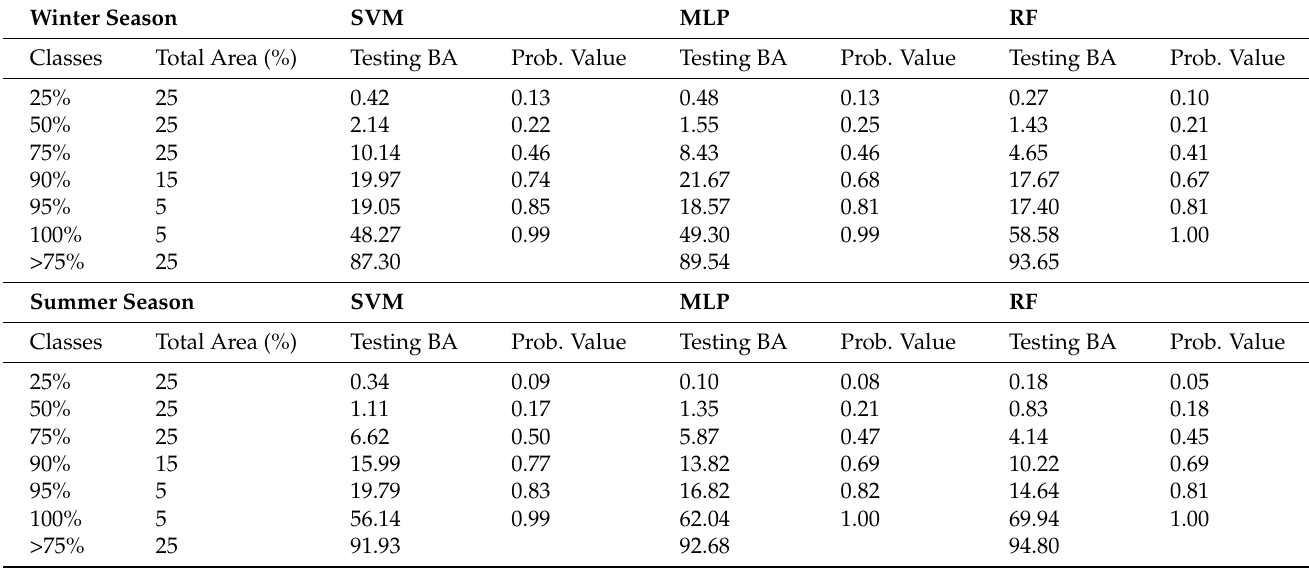
Figure 6. ROC curves for the three ML algorithms with the corresponding AUC values. Table 3 shows the percentage of burned area in the testing dataset (Testing BA) within each percentile class range (Classes) and the corresponding probabilistic predicted value (Prob. Value). The same percentile range’s limits can correspond to different values of the probabilistic output, allowing the competent authority the make decisions based on a given threshold for the highly susceptible area rather than on the raw output values. A model that predicts good results is expected to produce a higher percentage of the testing burned area within the highest percentile ranges and a lower percentage in the lowest ranges. Indeed, this is exactly what happened with the three algorithms (RF, MLP, and SVM) for both the seasons. Moreover, looking at the 25% of the area with the highest probability of burning (corresponding to the class >75%), results indicate that RF performs better that SVM and MLP: 93.65% of the test set’s burned area was predicted for winter and 94.80% for summer, compared to 89.57% and 87.30% for winter and 92.68% and 91.93% for summer for MLP and SVM, respectively. Likewise, given the area with the lowest probability of burning (corresponding to the class 25%), the three algorithms allocated a very low extent of test burned area for winter (0.27%, 0.48%, and 0.42% for RF, MLP, and SVM, respectively) and for summer (0.18%, 0.10%, and 0.34% for RF, MLP, and SVM, respectively). Table 3. Percentages of burned area in the testing subset belonging to different output percentile class ranges for SVM, MLP, and RF with neighboring vegetation. The last line for each season represents the top